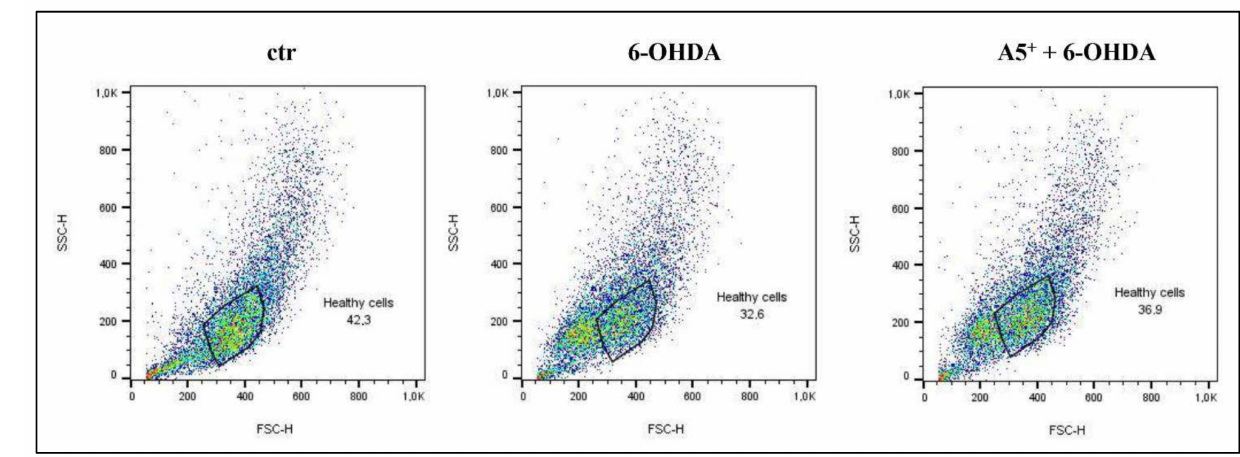
Figure 3. Cell shrinkage induced by 6-OHDA. Cytofluorimetric analysis reporting the alteration in cell structure and dimension following the neurotoxic insult. ctr: control; 6-OHDA: 6-hydroxydopamine.